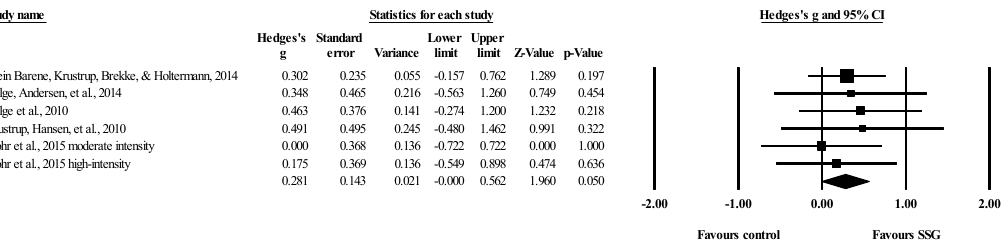
Figure 9. Funnel plot for changes in lower-body bone mineral density in untrained adults after a training program based on soccer small-sided games compared to a passive control condition. White circles: observed studies. Five studies provided data for lower body BMD, involving five experimental and six active control groups (pooled n = 195). Results showed a small effect of SSGs on lower body BMD (ES = 0.28; 95% CI = 0.00 to 0.56; p = 0.05; I 2 = 0.0%; Egger’s test p = 0.785; Figure 10) when compared to active controls. For the assessment of publication bias, a funnel plot is presented in Figure 11.